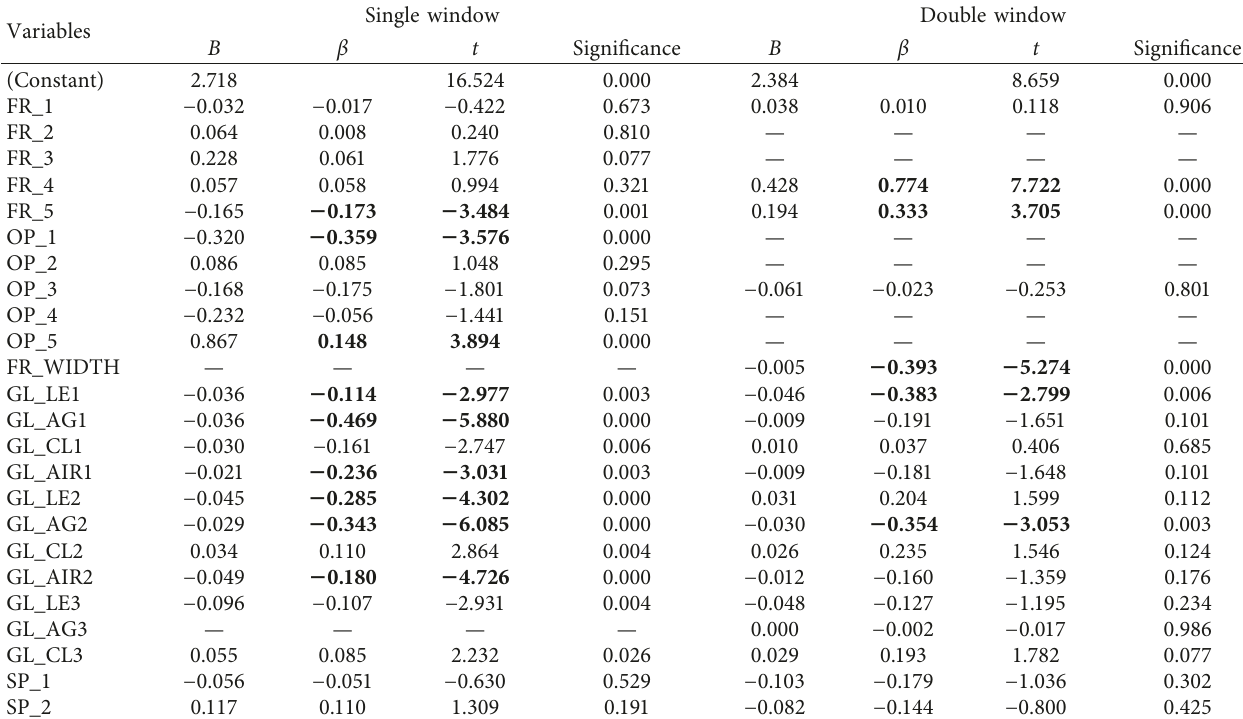
Table 6: Result of regression analysis: influences of each independent variable on U